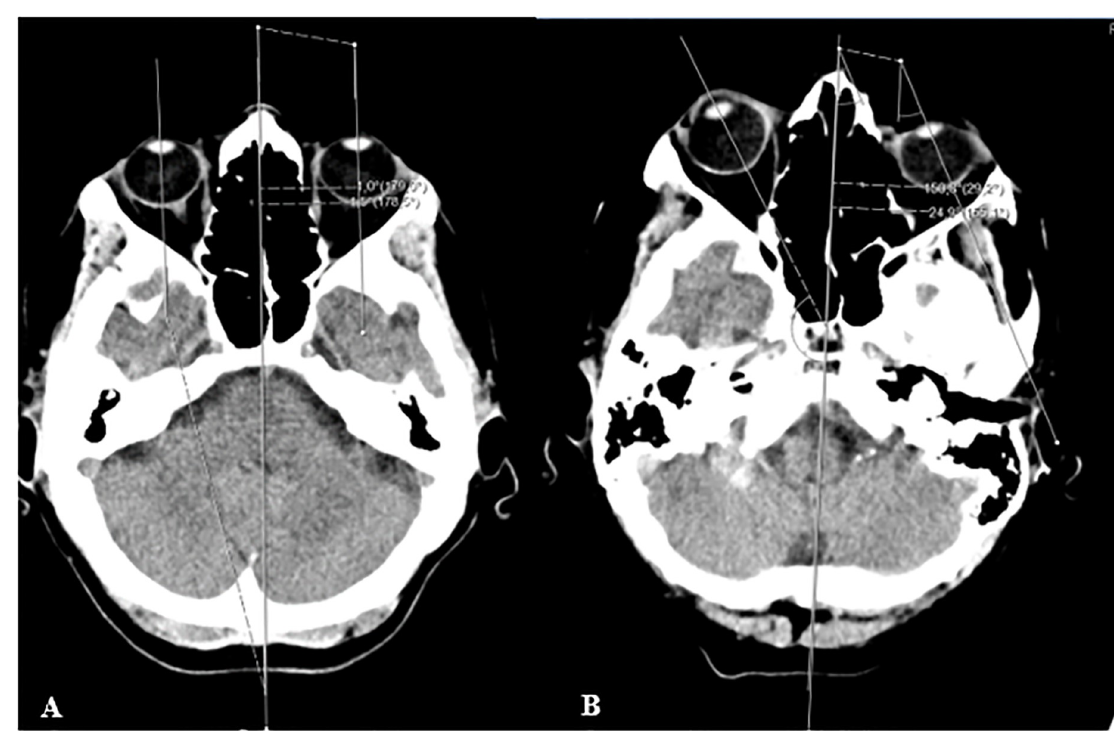
Fig 1. Measurement of the conjugated eye deviation (CED) on a healthy control subject with almost no deviation from midline (A) and on a patient with spatial neglect (B). A line was drawn through the middle section as a „line of best fit“, another two lines were drawn through the ocular axis [11]. The numbers correspond to the measured angles of intersection between the midline and the line of the respective ocular axis.